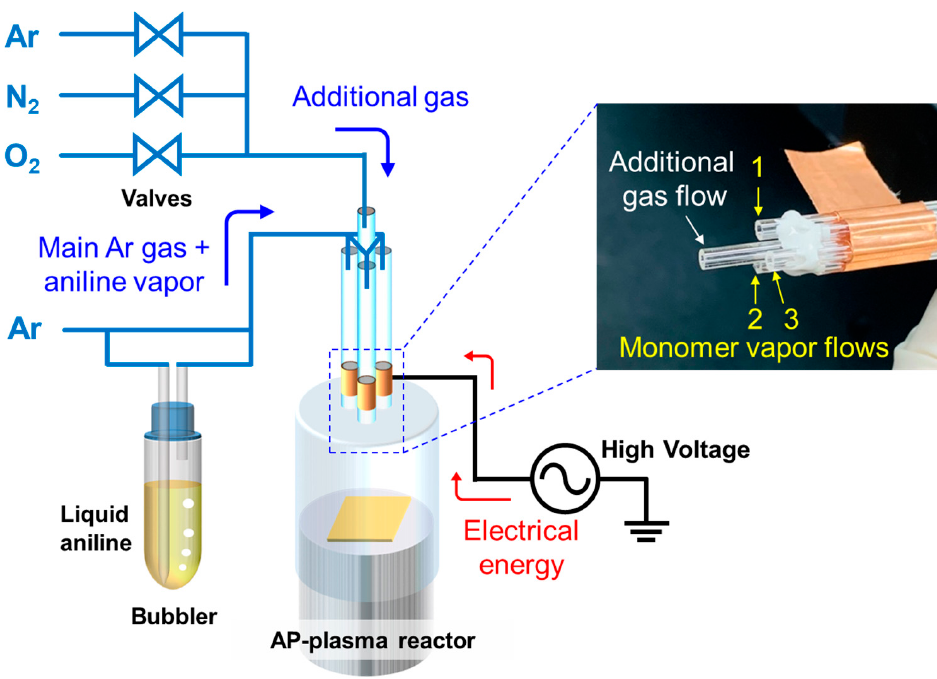
Figure 1. Experimental setup for the AP plasma polymerization system.